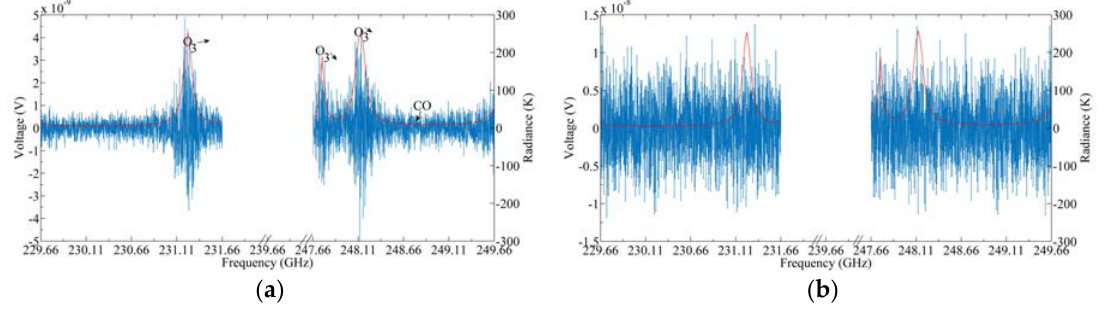
Figure 6. Thermal noise signal spectrum for the scene target in 240 GHz S5 upper and lower sidebands: ( a ) Tsys = 0 K; ( b ) Tsys = 1000 K.